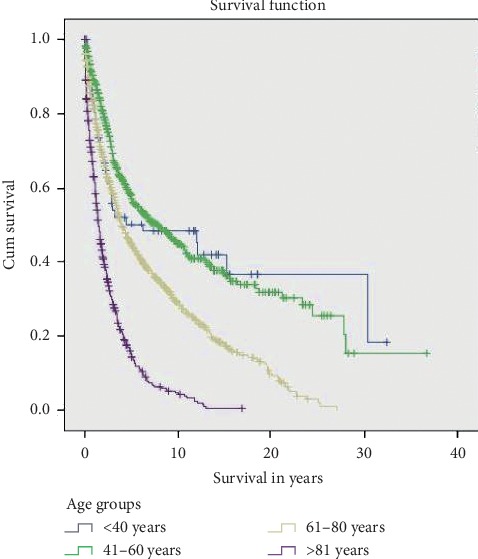
Kaplan–Meier plots showing overall survival among patients with anal canal adenocarcinoma (AA) based on age groups.